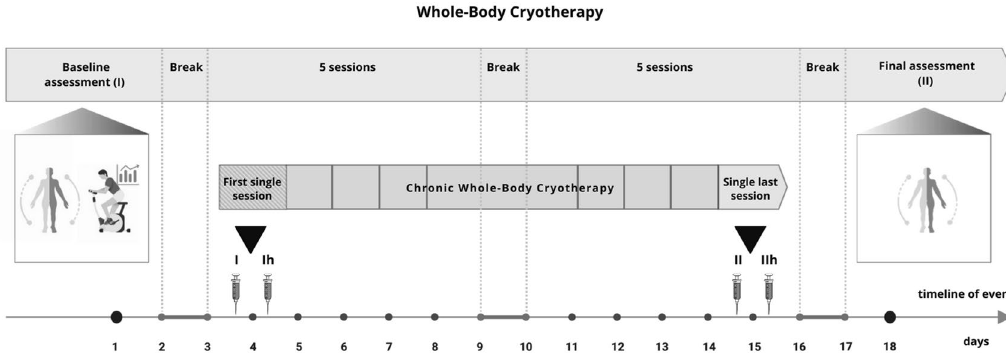
Figure 5. The experiment schedule. Blood collection: (I) before the first WBC session, (Ih) 1 h after the first WBC, (II) before the last WBC session and (IIh) 1 h after the last WBC session. Baseline assessment: body composition assessment and cardiorespiratory fitness measurement. Final assesment: body composition